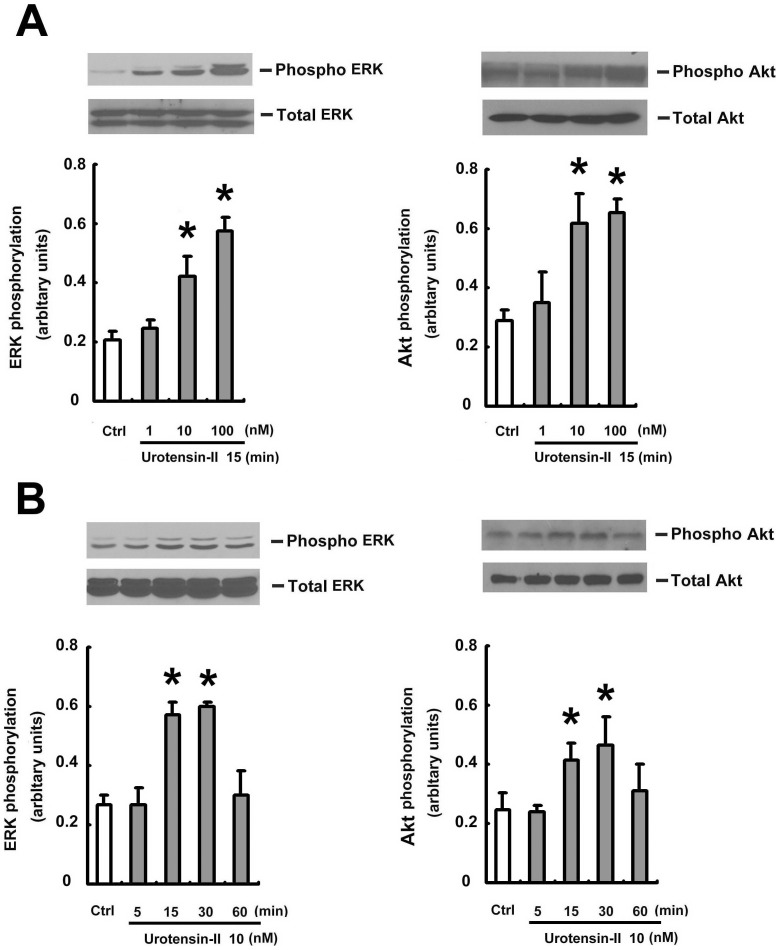
U-II induces Akt and ERK phosphorylation in HUVECs.(A) Effects of U-II on phosphorylated of Akt and ERK. HUVECs were incubated with 15 min with U-II for the indicated doses. (B) Effects of U-II on phosphorylation of ERK and Akt. HUVECs were incubated with 10 nM U-II for the indicated times. (A) and (B) Western blot analyses were performed using site- and phospho-specific ERK antibodies against Thr202/Tyr204 (p- ERK, upper blot) or total ERK (lower blot) (A). phospho-specific Akt antibodies against Ser473 (p-Akt, upper blot) or total Akt (lower blot) (B). Densitometric data are means ± SEM from three separated experiments. *P <0.05 vs. control (Ctrl).